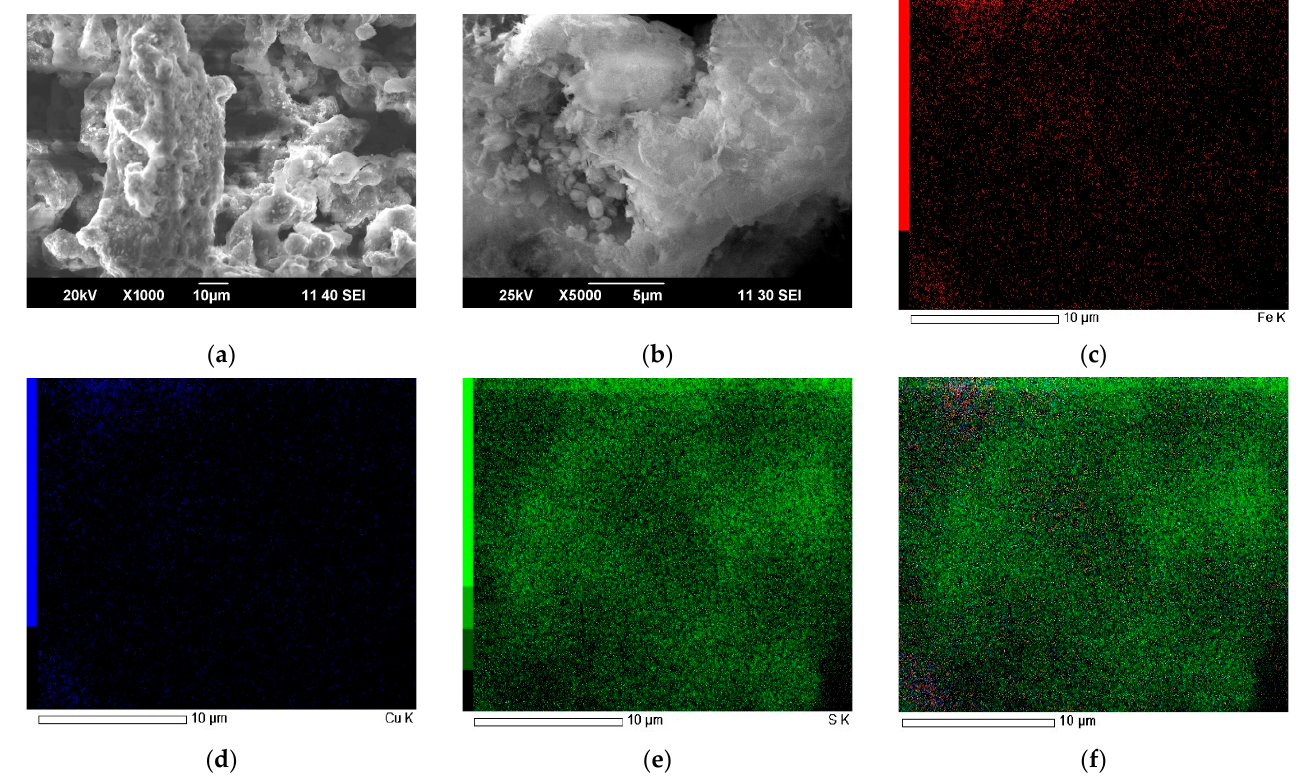
Figure 6. SEM images of synthetic concentrate-leaching residue ( a , b ) and EDX-mapping of the residue for Fe ( c ), Cu ( d ), S ( e ) and combined ( f ). (300 rpm; 353 K; 6 mol/L H 2 SO 4 ; 0.018 mol/L Fe (III); 60 min; no FeS 2 additive).